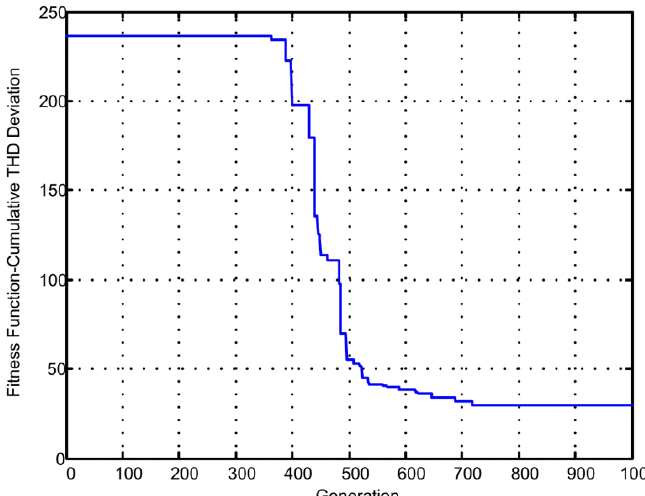
Figure 6. Cumulative voltage THD over the GA iterations (High EV Penetration). Table 9. THD of Phase to Phase Voltages in High EV Penetration.